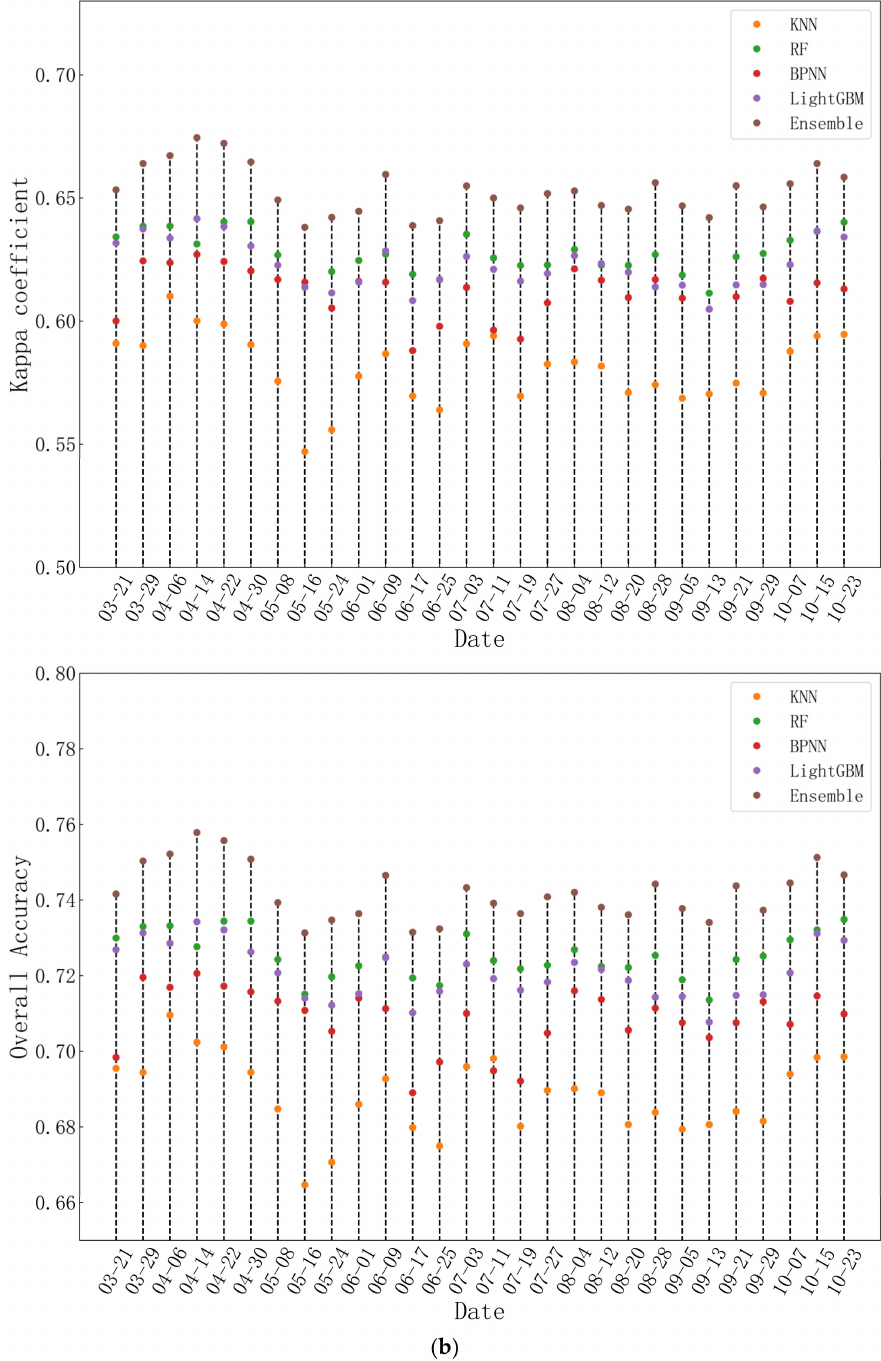
Figure 9. Overall accuracy and kappa coefficient of Experiments 1 and 2. ( a ) Experiment 1 (spectral features only). ( b ) Experiment 2 (spectral plus topographic